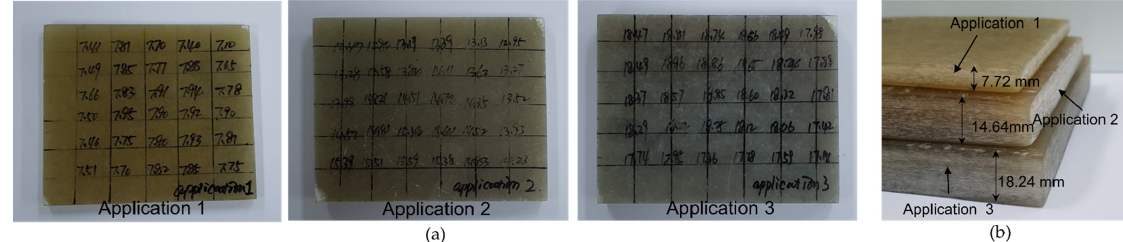
Table 2. Design properties of the hull plates used for thickness measurement error determination.